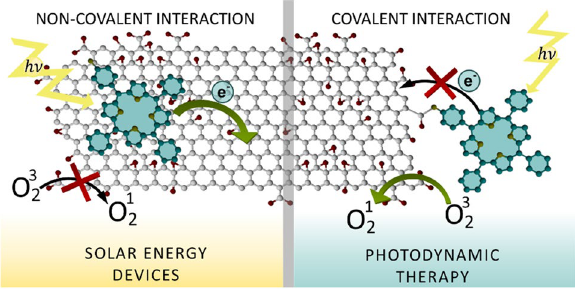
Figure 14. Schematic representation of the influence of the porphyrin/GO hybrid functionalization type on their interaction with